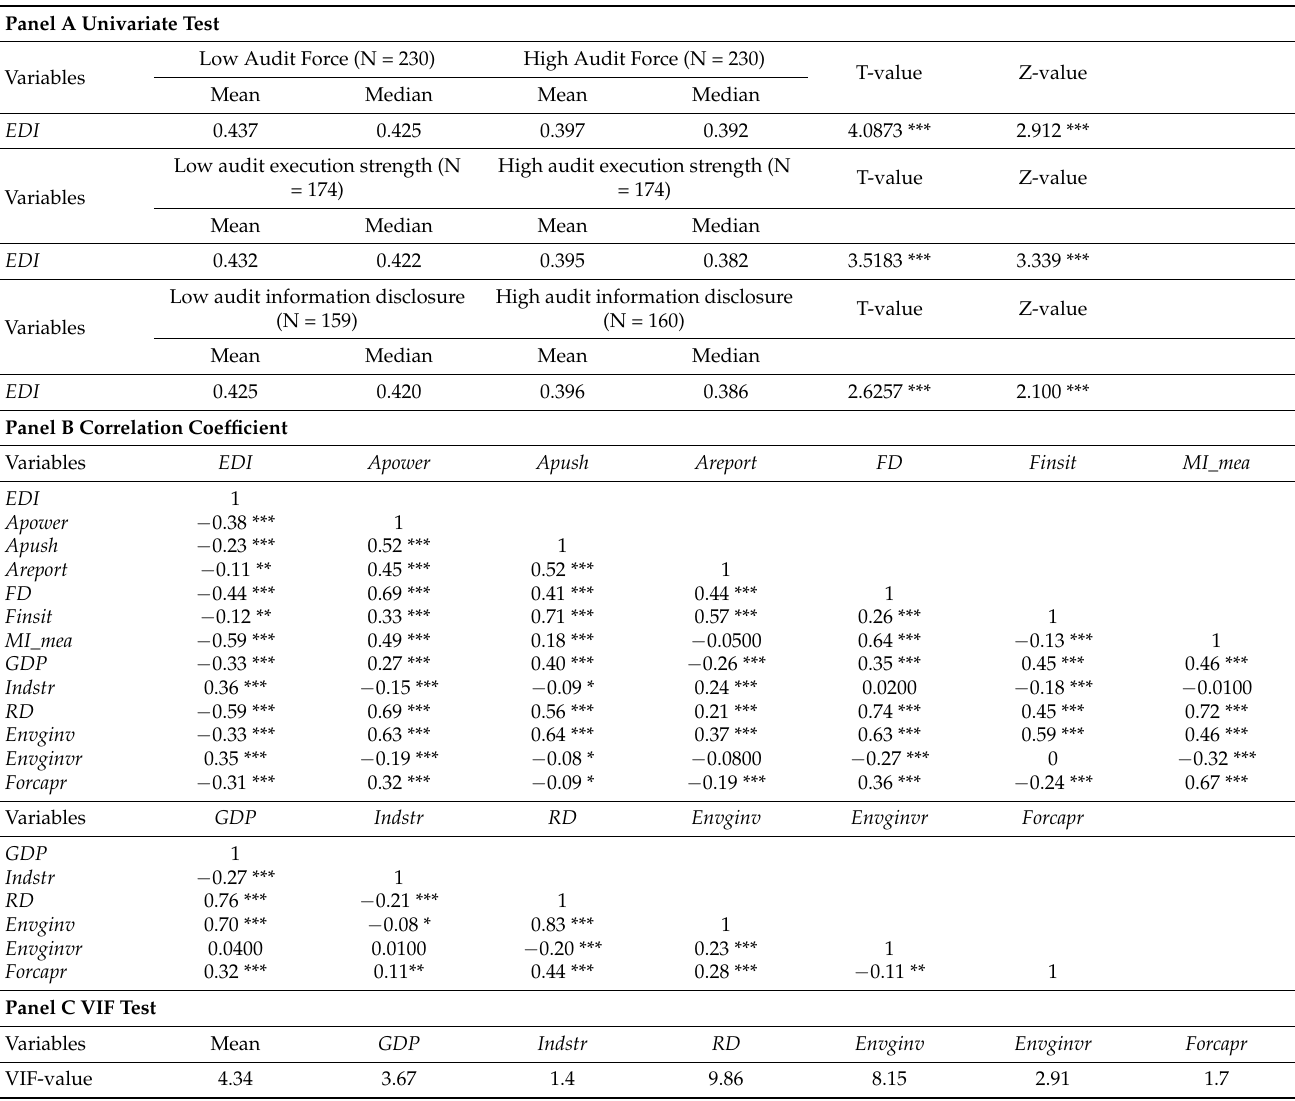
Table 4. Univariate tests, correlation coefficients and VIF